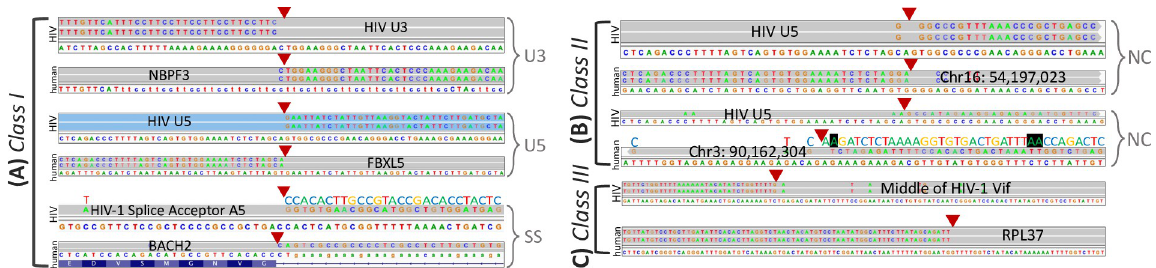
Fig 6. Venus’s classification of integration sites on HIV. Reference sequences of each species are at the bottom of each read. Due to converging HIV and human gene orientations, some sequences require reading their complements, written above in colorful letters. (A) Class I Integration Sites: human reading into HIV U3 sequence (U3), HIV U5 reading into human sequences (U5), or known splice sites from both species (SS) (B) Class II Integration Sites: U5 or U3 sequences that read into noncoding human regions (NC), differentiated by genomic coordinates (C) Class III Integration Sites: sites mapped to the middle of HIV